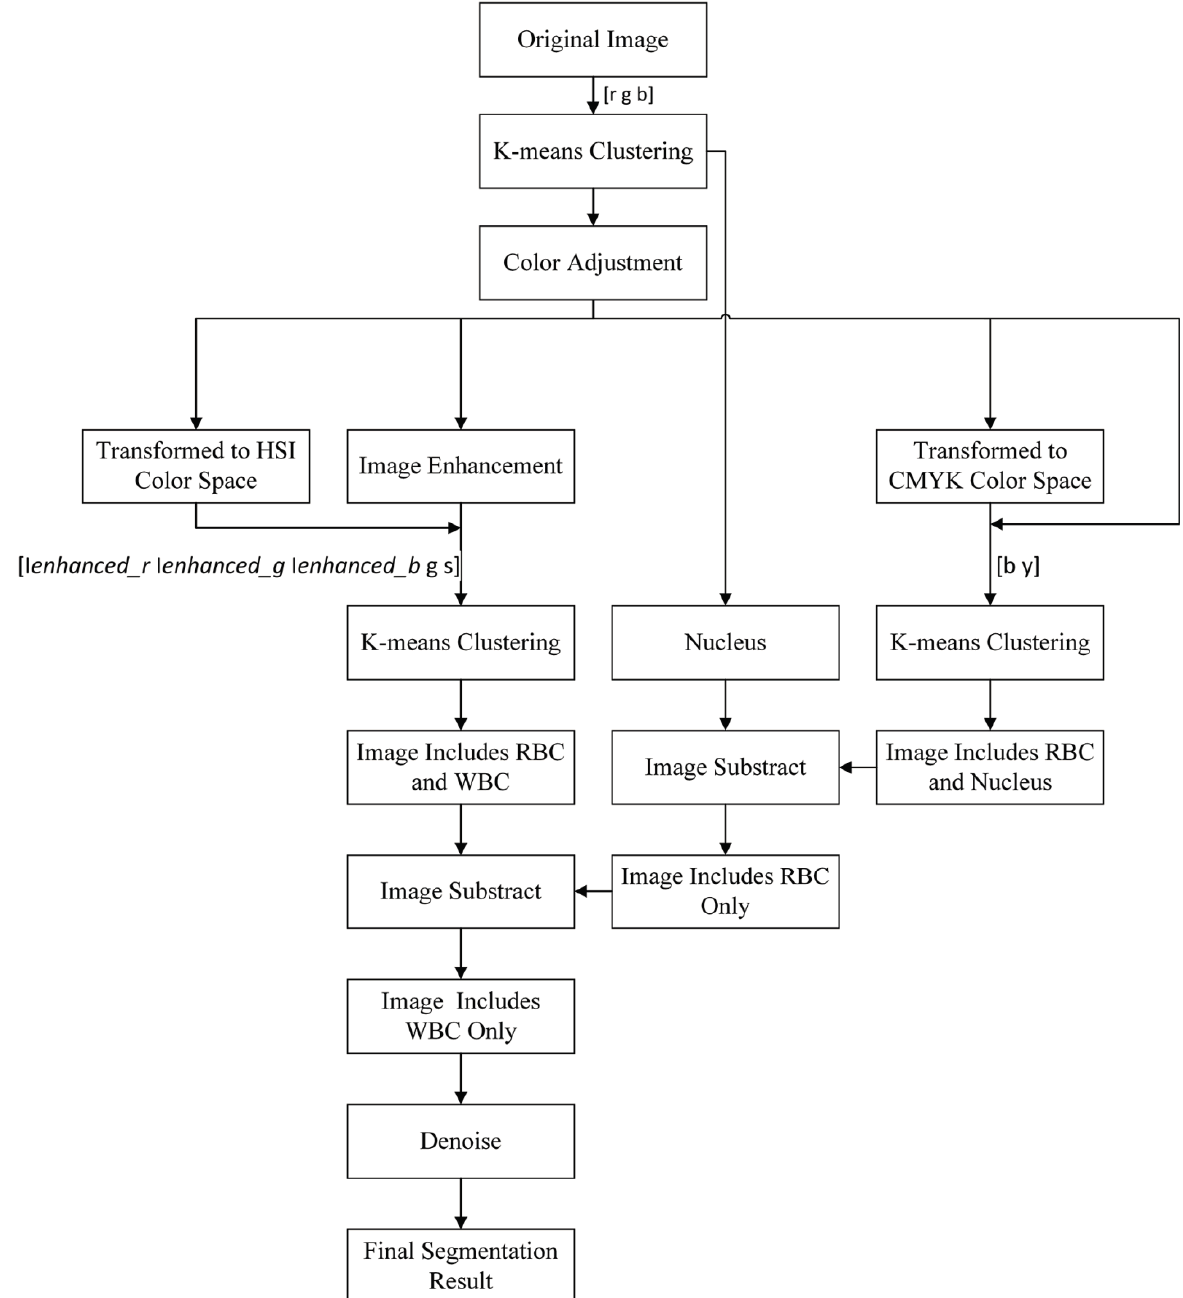
Figure 3. Flow chart of the proposed